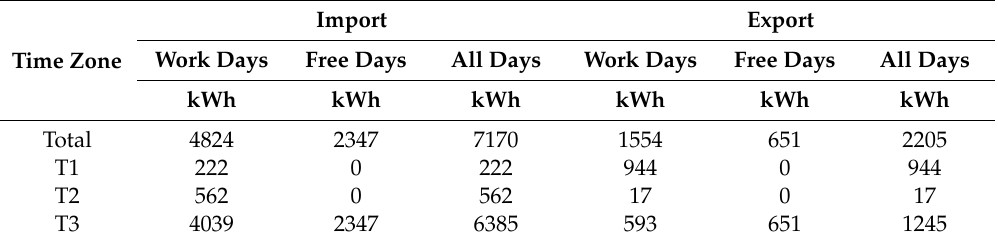
Table 4. Sum of imported and exported energy in the summer and heating seasons, and all year, for work days, free days and all days. Import Export All Days Time Zone